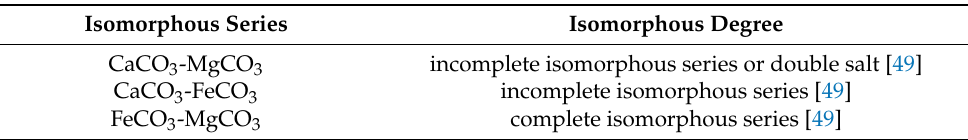
Table 2. Isomorphism among different